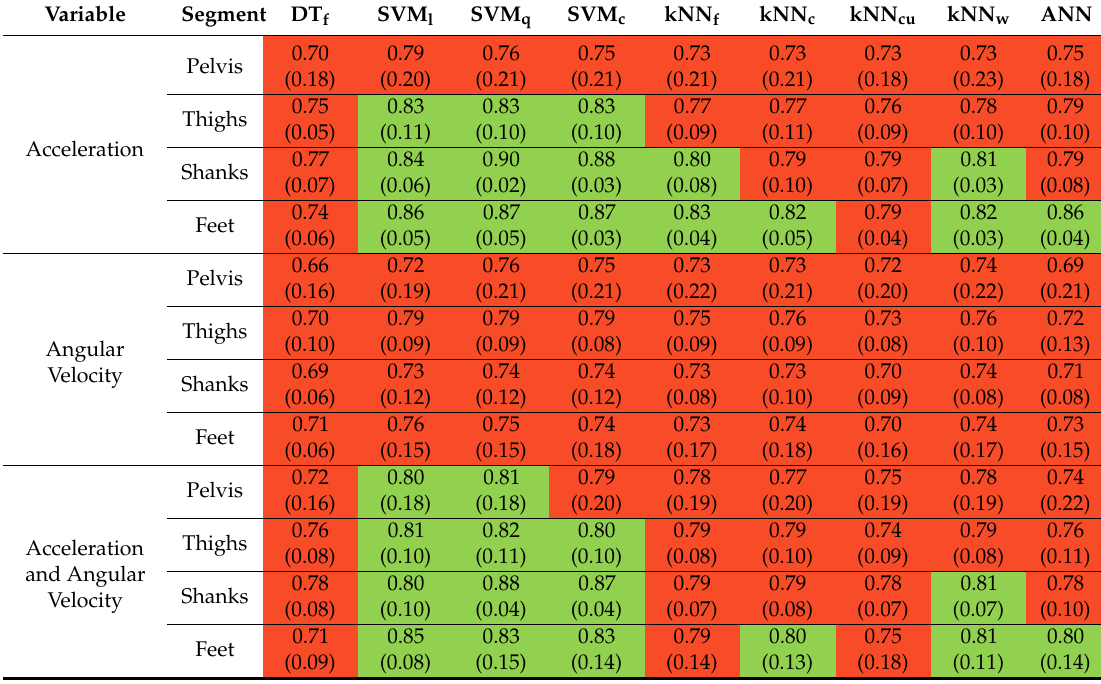
Table 3. Mean and standard deviation of the overall accuracy. The green cells represent classifiers that passed the first selection; others are highlighted in